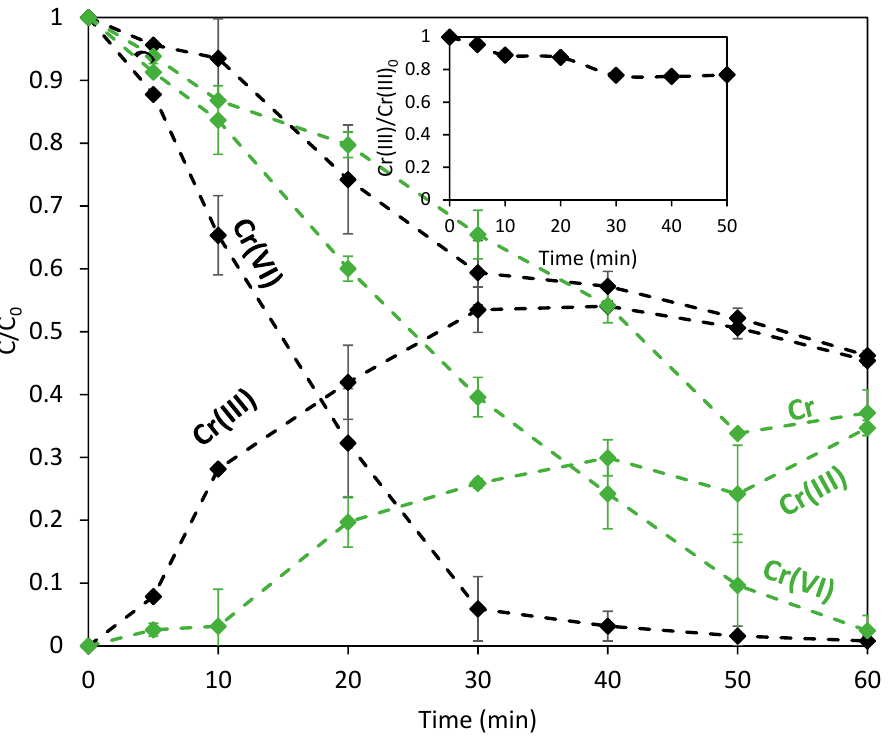
Figure 5. Normalized time-resolved Cr(VI), Cr(III), and Cr curves for chromium removal experiments with 1 g of NSTAR@AL (black) and 1 g of NSTAR@AL + 1 g of AL (green). Insert: Removal of Cr(III) with 1 g of AL beads. [Cr] = 64 µM, pH = 3, T = 25 °C. 0 The removal performance of Cr(III) with bare AL beads was evaluated, and the re- sults are depicted in the insert of Figure 5. After 50 min of treatment, around of 23% of the Cr(III) initially present in the solution was removed by the adsorption of AL beads. There- fore, it is possible to calculate that NSTAR are responsible for the retention of c.a. 32% of Cr(III) generated by the reduction of Cr(VI), as in the Cr(III) removal experiment, we used the same Cr initial concentration as in the rest of this work.